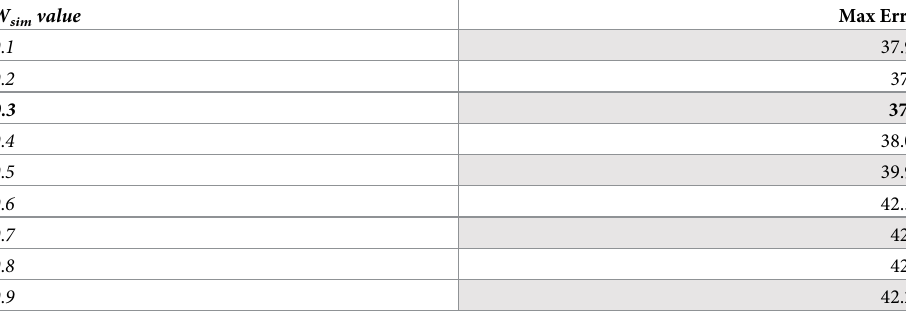
Table 1. Results of the preliminary experiment for W sim